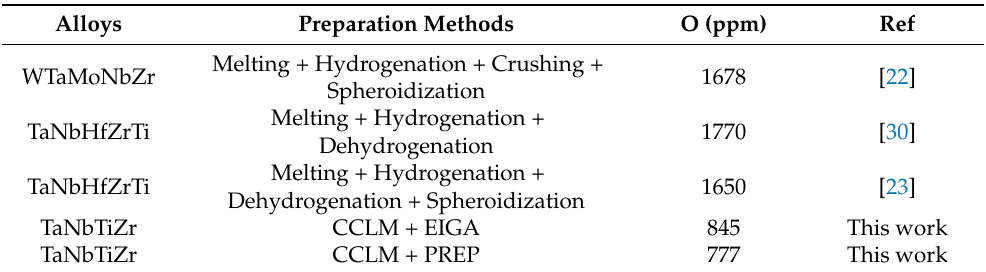
Table 2. Comparison of the oxygen content of the spherical TaNbTiZr RHEA powders with other similar RHEA powders prepared by different